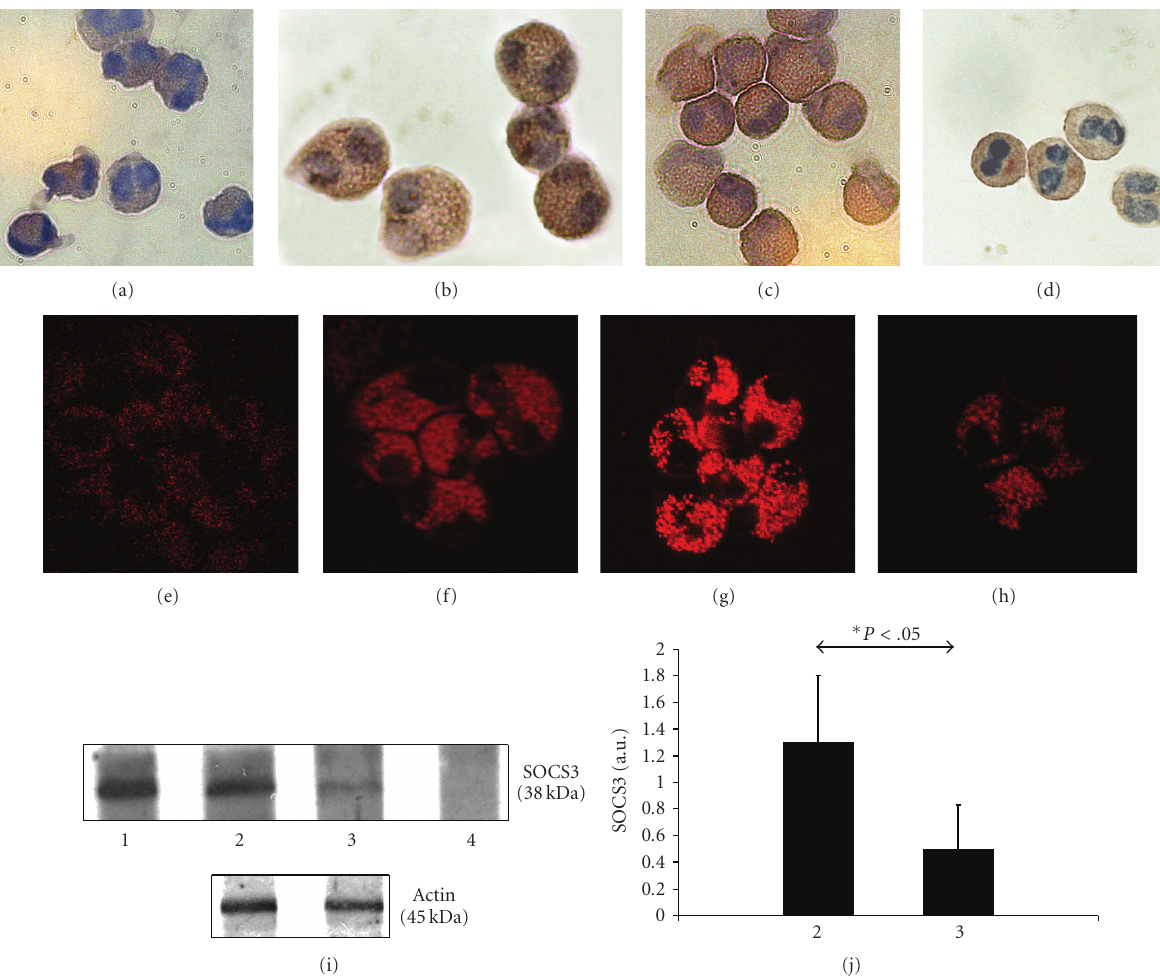
Figure 2: SOCS3 expression in peripheral blood eosinophils from Th2 patients analyzed by immunohistochemical, immunofluorescence, and Western blot techniques. Eosinophils from asthmatic and NAEB patients within healthy controls were adhered to slides and incubated with peroxidase-conjugated goat antirabbit IgG against SOCS3 antibody ((b), (c), and (d)) or rabbit IgG as a control (a), and Texas Red conjugated goat antirabbit IgG against SOCS3 antibody ((f), (g), and (h)) or rabbit IgG as a control (e). The slides were observed by optical ((a), (b), (c), (d)) or confocal ((e), (f), (g) and (h)) microscopy. Western blot analysis of the cytosolic extract of purified eosinophils was achieved using antibody against SOCS3 (i). Lane 1: recombinant SOCS3was loaded as a positive control; lane 2: eosinophillysate from NAEB patients; lane 3: eosinophil lysate from healthy control patients; lane 4: isotype negative control. The picture is a representative example of 5 individuals, all displaying similar results. (j): SOCS3 bands were quantified by densitometry and corrected by actin expression; data are expressed as the mean ± SD, n = 5, ∗ P < . 05 (2: NAEB; 3: healthy